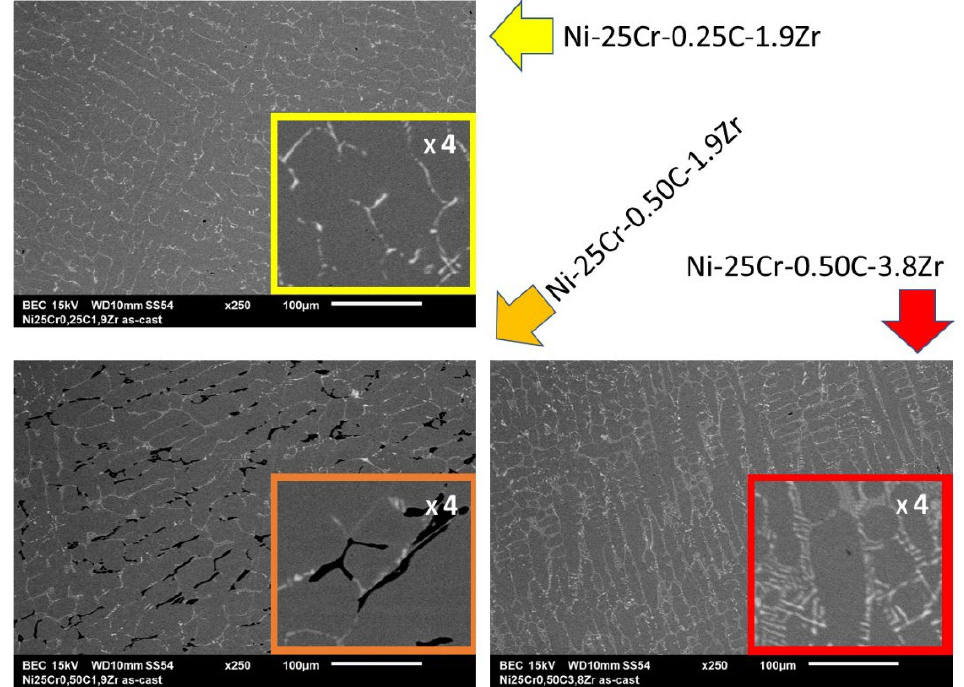
Figure 1. Microstructures of the three Zr–containing alloys in their initial states ( top : the Ni–25Cr– 0.25C–1.9Zr alloy, bottom left : the Ni–25Cr–0.50C–1.9Zr alloy, bottom right : Ni–25Cr–0.50C–3.8Zr).